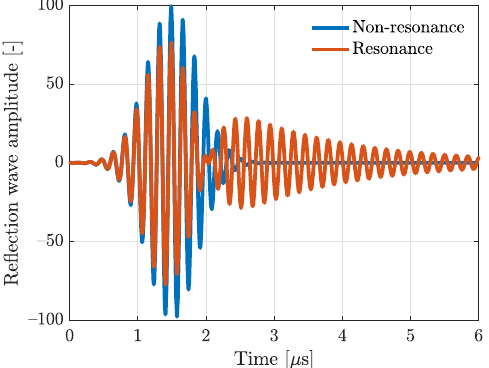
Figure 4. Illustration of ringing within the lubrication